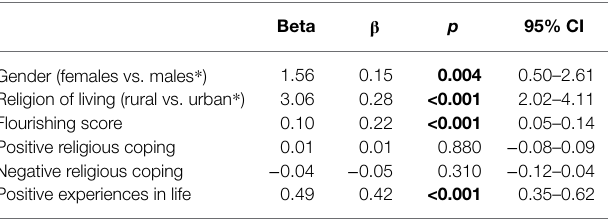
TABLE 4 | Multivariable analysis: Linear regression (using the ENTER model) taking the positivity score as the dependent variable. Beta β p 95% CI Gender (females vs. males *